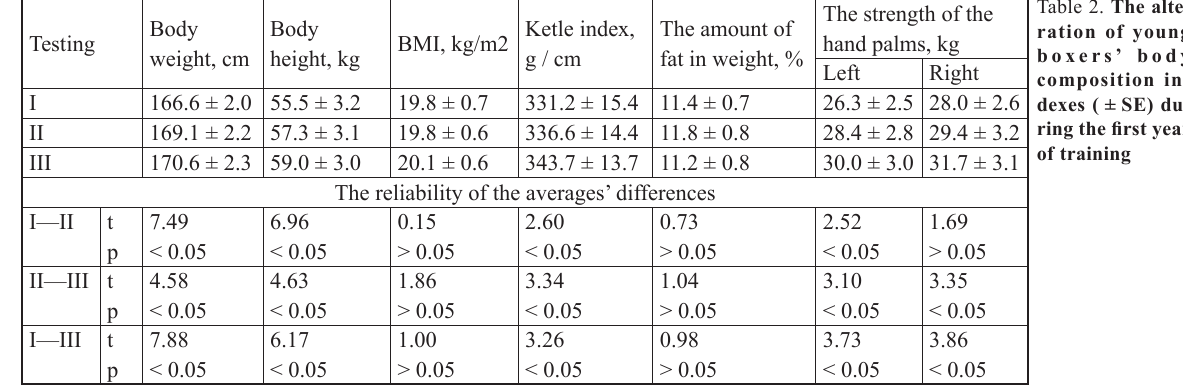
Table 2. The alte- ration of